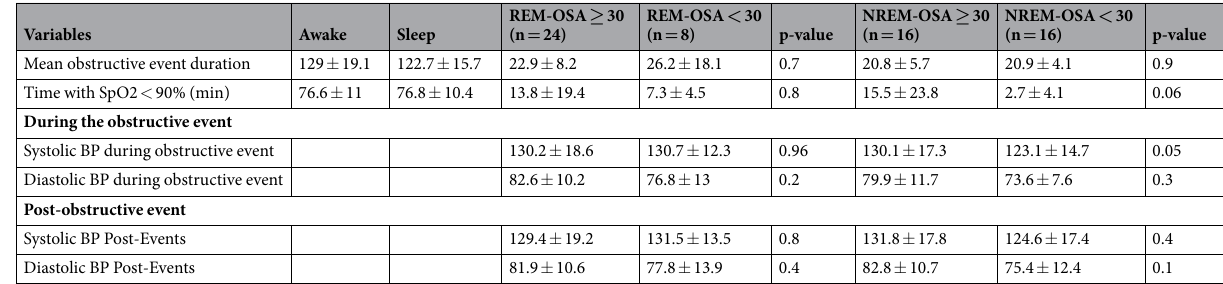
Table 5. Comparisons between patients with severe and mild to moderate OSA in REM and NREM